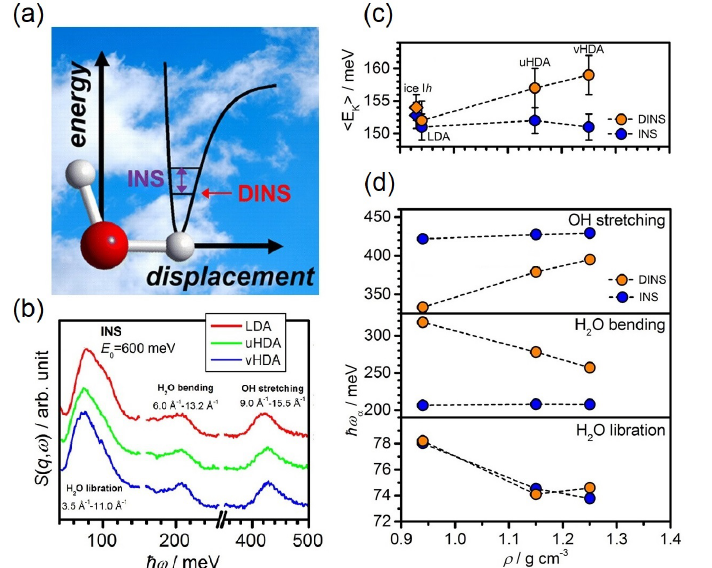
Figure 15. ( a ) Pictorial representation of the anharmonic potential of the OH-stretch mode of H 2 O. The vibrational ZPE measured with NCS (DINS), as well as the fundamental 0 → 1 transition probed with INS, are highlighted. ( b ) Experimental INS spectra of different forms of amorphous ice (LDA, red; unannealed HDA, green; and vHDA, blue) measured at T = 80 K on MARI. The spectra were obtained after averaging over the indicated Q -range. ( c ) Mean kinetic energies (<E K >) from NCS (orange) and corresponding values obtained from INS using the harmonic model discussed in Ref. [399] (blue). ( c ) Energies of the OH-stretch, bend, and librational modes of H 2 O, obtained from INS (blue), as well as the corresponding values derived from NCS (orange). Adapted with permission from Ref. [391]. Copyright (2021) American Chemical Society.